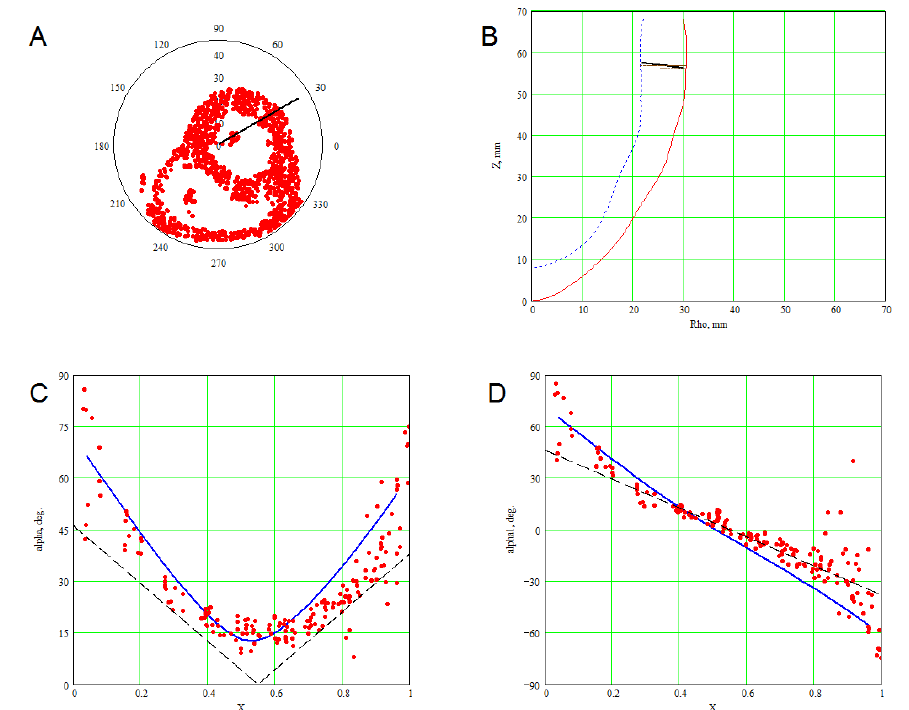
Figure 7. Fiber angles in the model and in the experimental data. The basal area ( ψ = 10 ◦ ) of the LV free wall is shown. ( A ) A horizontal LV section. The points are myocardial points from a human heart DT-MRI scan. ( B ) A meridional LV section. The solid (dashed) curve is the model epicardium (endocardium), and the points are myocardial points from the DT-MRI scan. ( C , D ) The angles α and α 1 , respectively. The X -axis displays the position of points in the wall depth; 0 corresponds to the endocardium, and 1 corresponds to the epicardium. The points show the experimental data, while the solid curves show our model data, and the dashed curves display results yielded by the model from